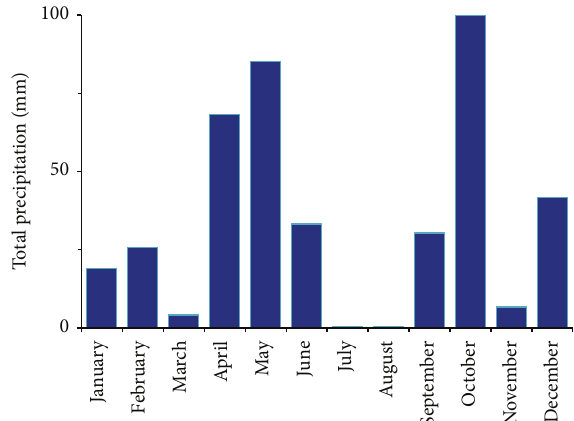
Figure2:Summaryofprecipitationrecordedin2008bytheweather station in Madrid.